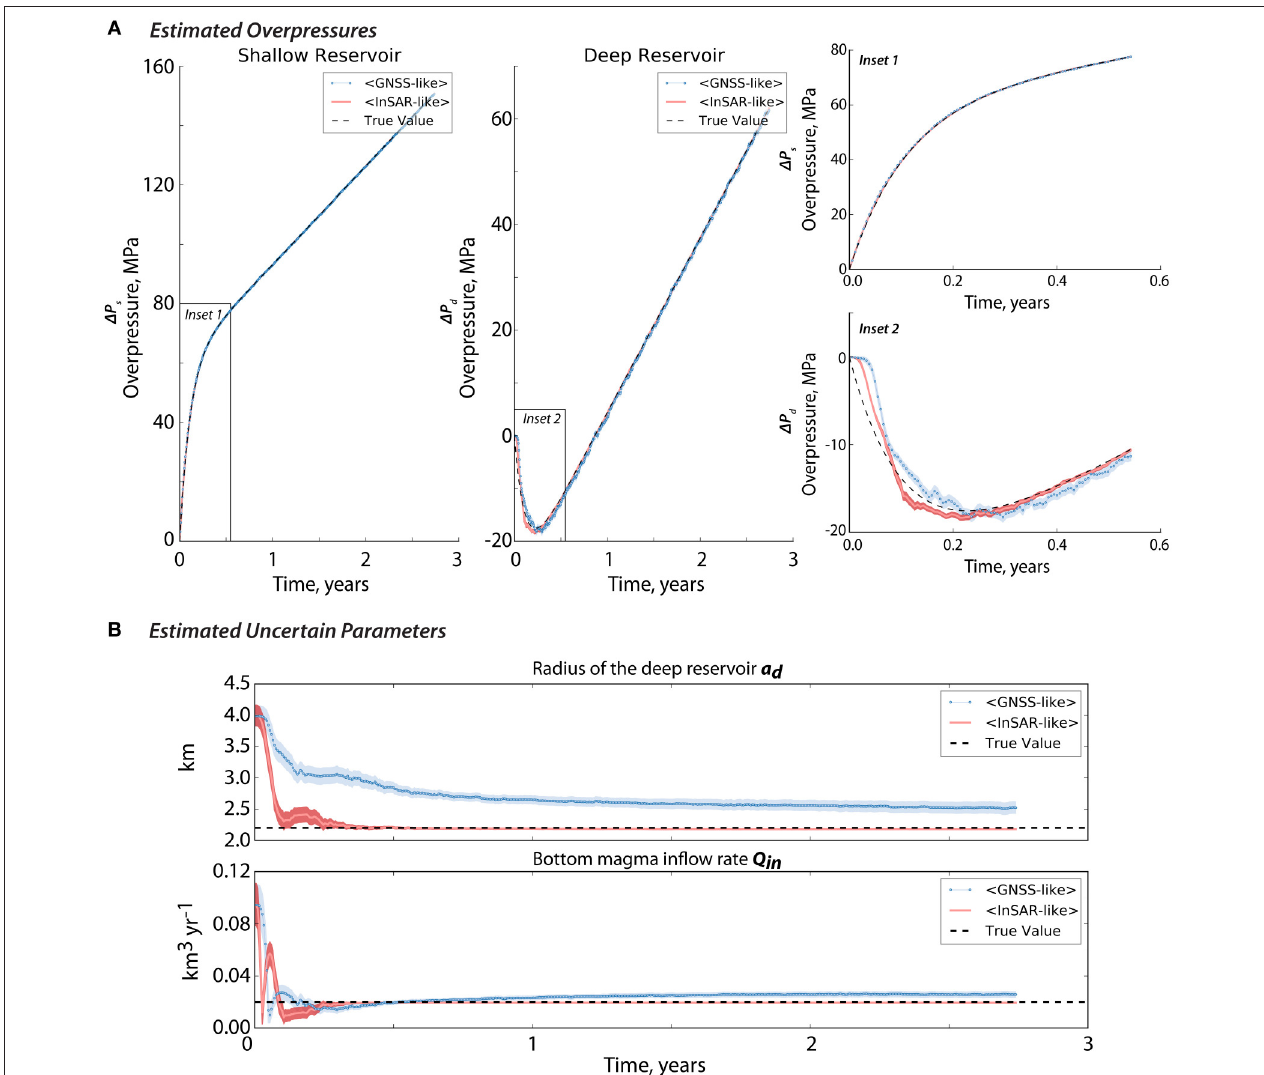
FIGURE 10 | Influence of the spatial density of observations on the assimilation: GNSS (10 observations that are assimilated every time-step, f obs to the volcanic center ranging from 1 to 5 km) vs. InSAR-like dataset (242 observations that are assimilated every time-step, f obs center ranging from 1 to 5 √ 2 km). (A,B) illustrates the estimated overpressures and uncertain parameters, respectively, given that the initial conditions of the uncertain parameters are similar to those of in Figure 5C . The insets in (A) provide a closer look on the overpressures at the beginning of the assimilation. The light blue and red shades correspond to the spreads (1 σ ). Note that for the overpressures, the spreads are difficult to discern since they are very small when compared to the scale of the plot. The black broken lines represent the true